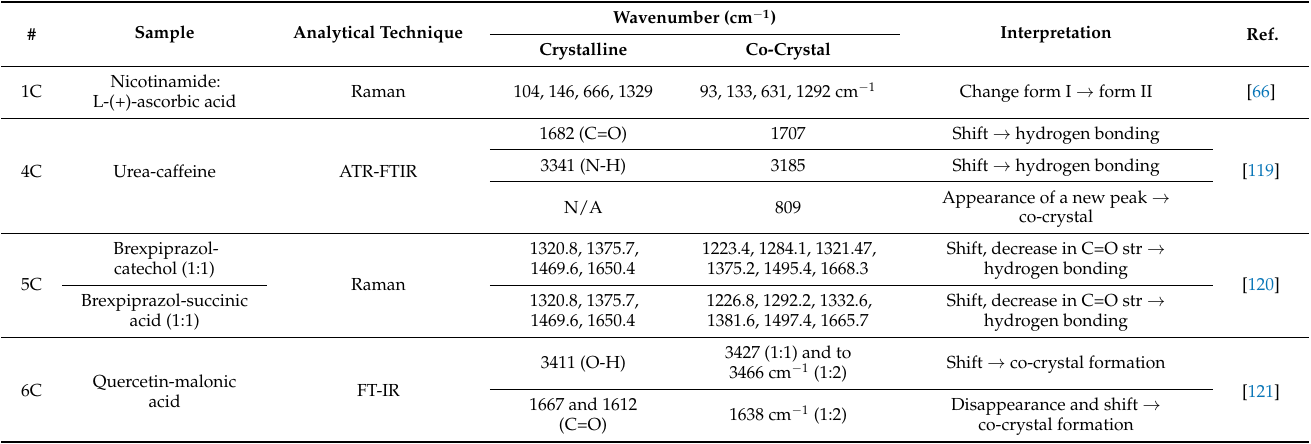
Table 7. Overview of structural characterization by spectroscopy of drug co-crystals obtained by